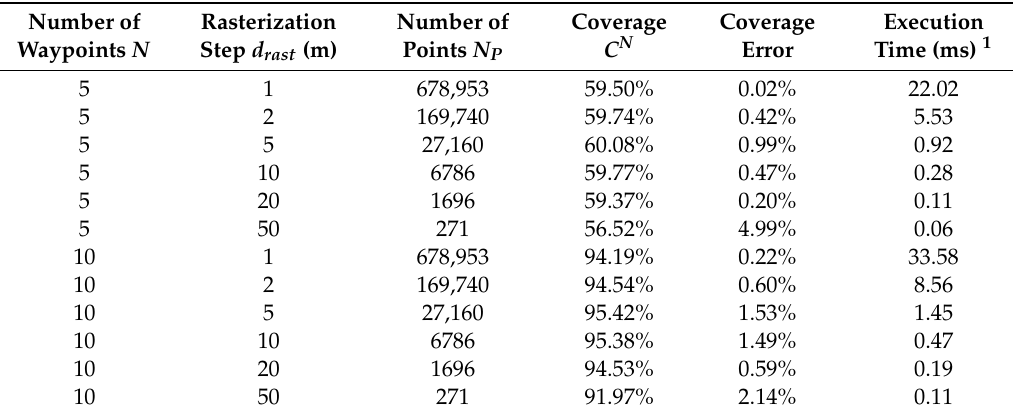
Table 2. Experiments with the solution evaluation via the optimized